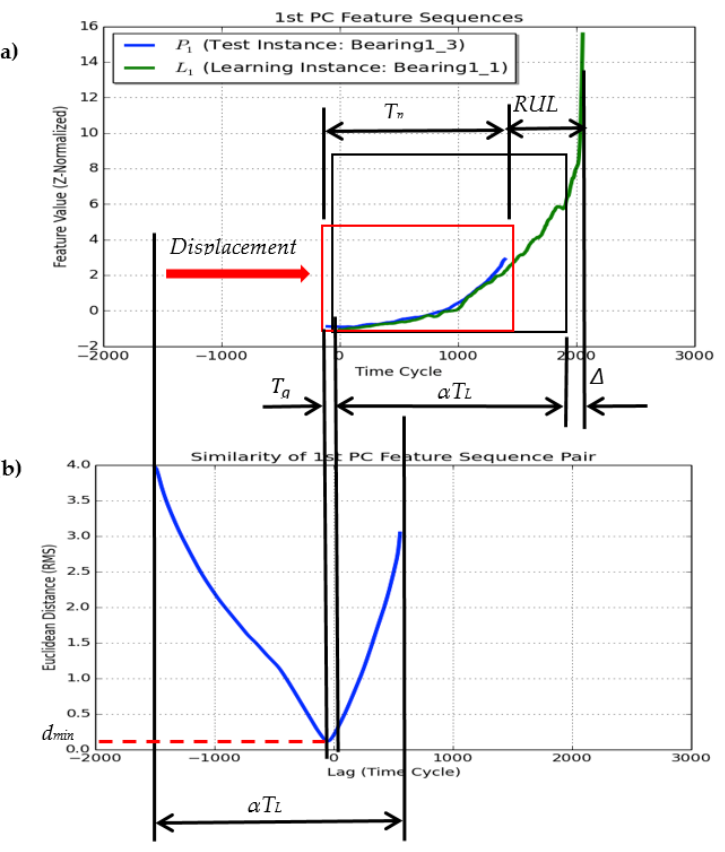
Figure 6. Similarity evaluation. ( a ) Similarity matching between the learning instance Bearing1-1 and the test instance Bearing1-3; ( b ) Similarity measure function.